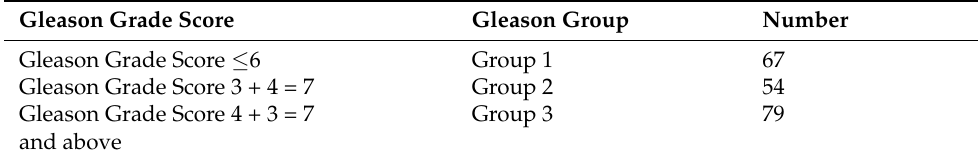
Table 1. Demographic data and Gleason grouping.